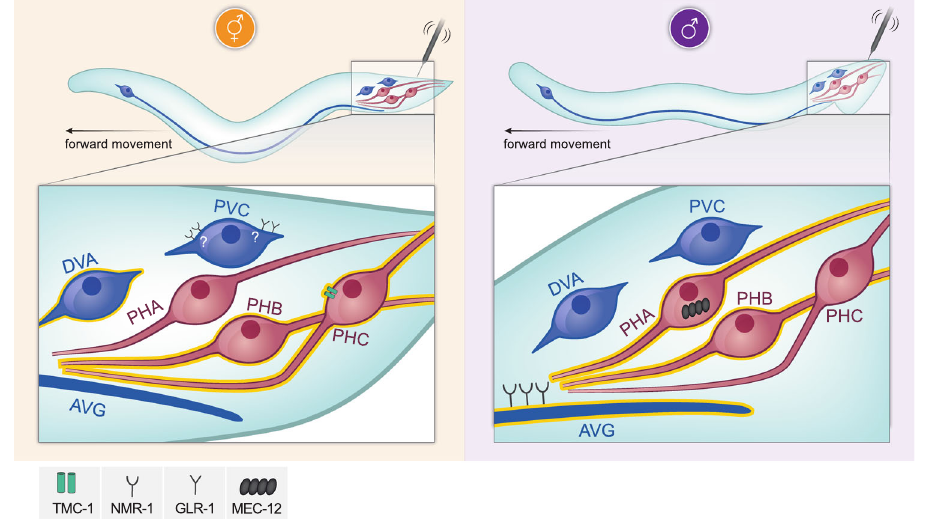
Fig. 8 | Sexuallydimorphiccellularand molecular mechanismscontrolling tail mechanosensation. A model depicting the cellular and molecular elements med- iating tail mechanosensation in each sex. Neurons that function in each sex are